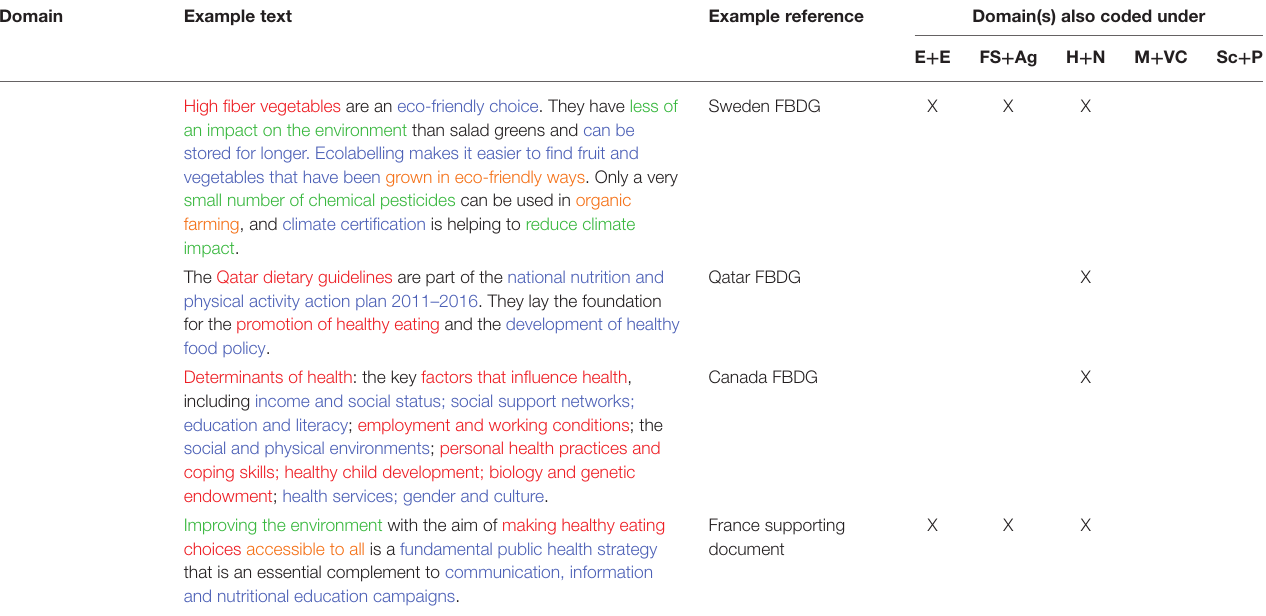
Figure 1 ). This reformatting adapted Downs et al.’s grouping of concentric circles by overlapping circles in a five-part Venn diagram that indicates a blurring of their heretofore distinct domains. This study thus presents an adpatation of the Downs’ framework, in that it depicts interconnectivity through conceptual overlaps and definitions that encompass wider understanding of the concepts. Selected examples of interconnected text from each document examined are given